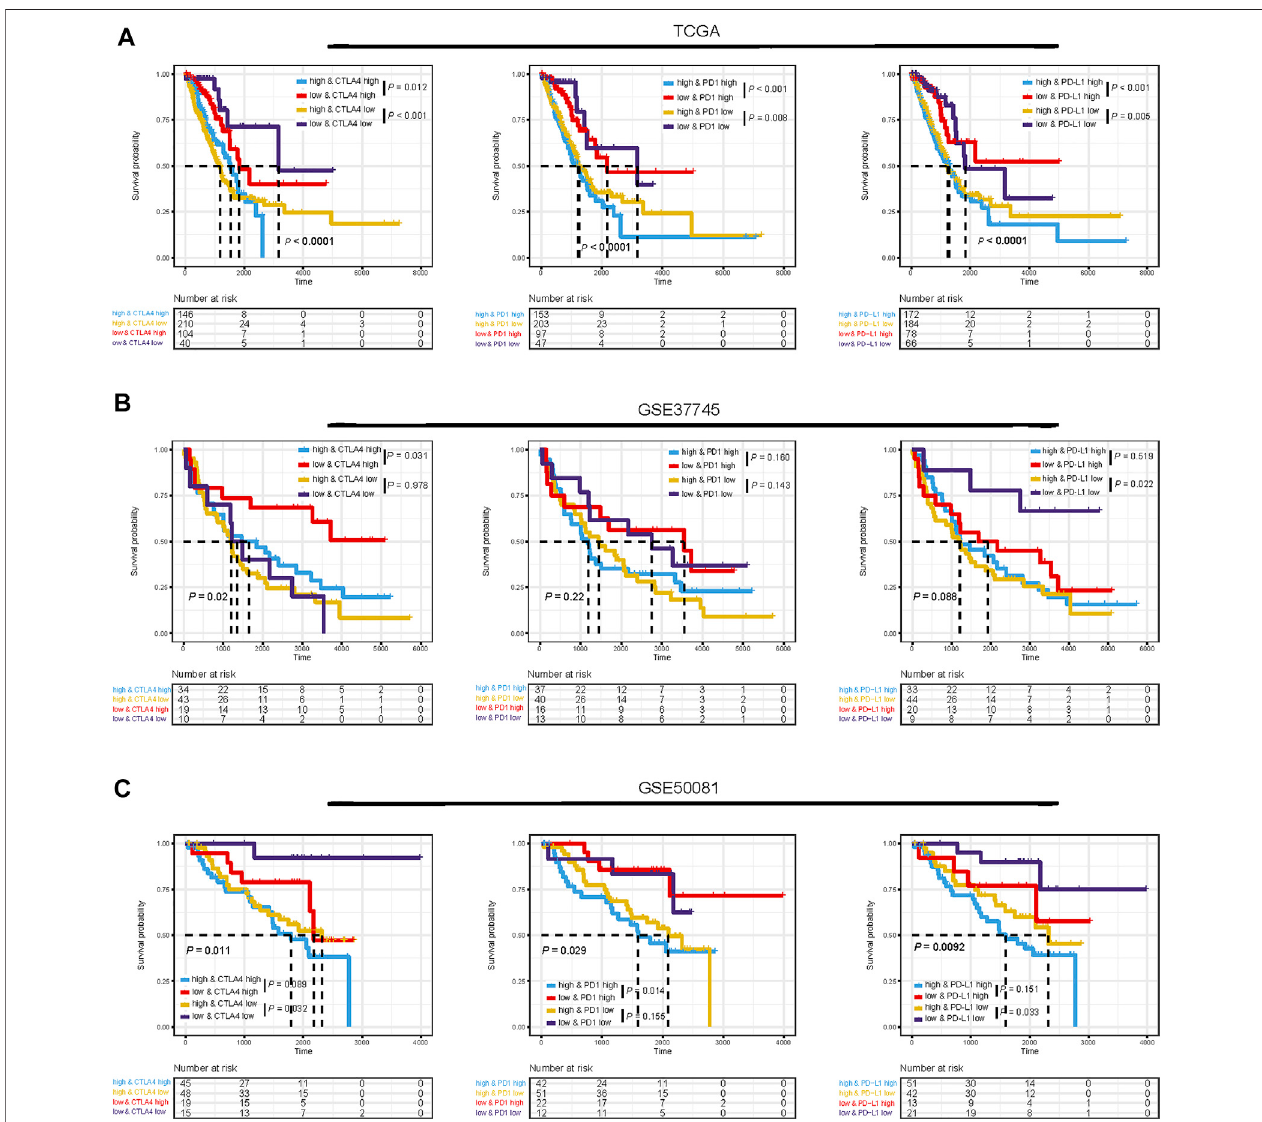
FIGURE7| ImpactofimmunecheckpointgeneexpressionsandTMEscoreonclinicaloutcome.Kaplan – Meiersurvivalcurvesofoverallsurvivalamongfourpatient groups strati fi ed by TMEscore and immune checkpoint genes (PD1, PD-L1, and CTLA-4) in TCGA dataset (A) , GSE37745 dataset (B) , and GSE50081 dataset (C) .